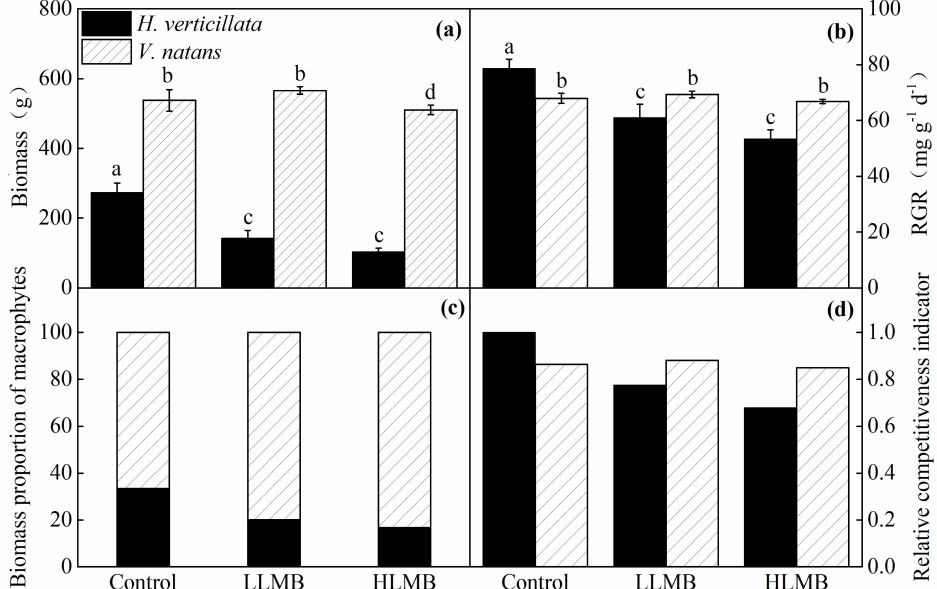
Figure 4. Biomass ( a ), relative growth rate ( b ), biomass proportion ( c ), and relative competitiveness indicator ( d ) of H. verticillata and V. natans . Factor was LMB (0, 425 g m − 2 , and 850 g m − 2 ). The values represented a standard deviation ( n = 4). Means with different letters (a, b, c, and d) were significantly different ( p <